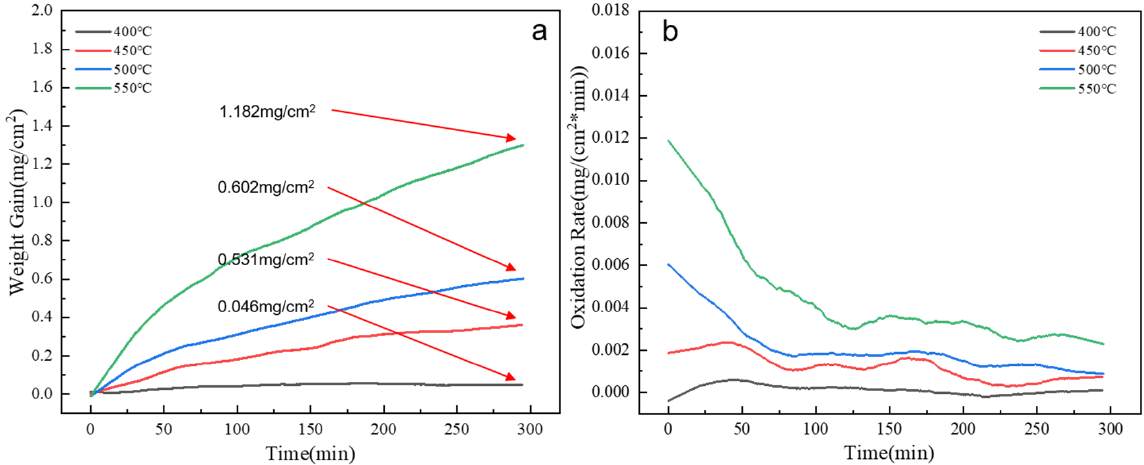
Figure 4. ( a )The weight gain curve of Al–2Li–0.2Sc alloy exposed for 5 h; ( b )The weight gain rate Figure 4. ( a ) The weight gain curve of Al–2Li–0.2Sc alloy exposed for 5 h; ( b ) The weight gain rate curve of Al–2Li–0.2Sc alloy exposed for 5 h. curve of Al–2Li–0.2Sc alloy exposed for 5